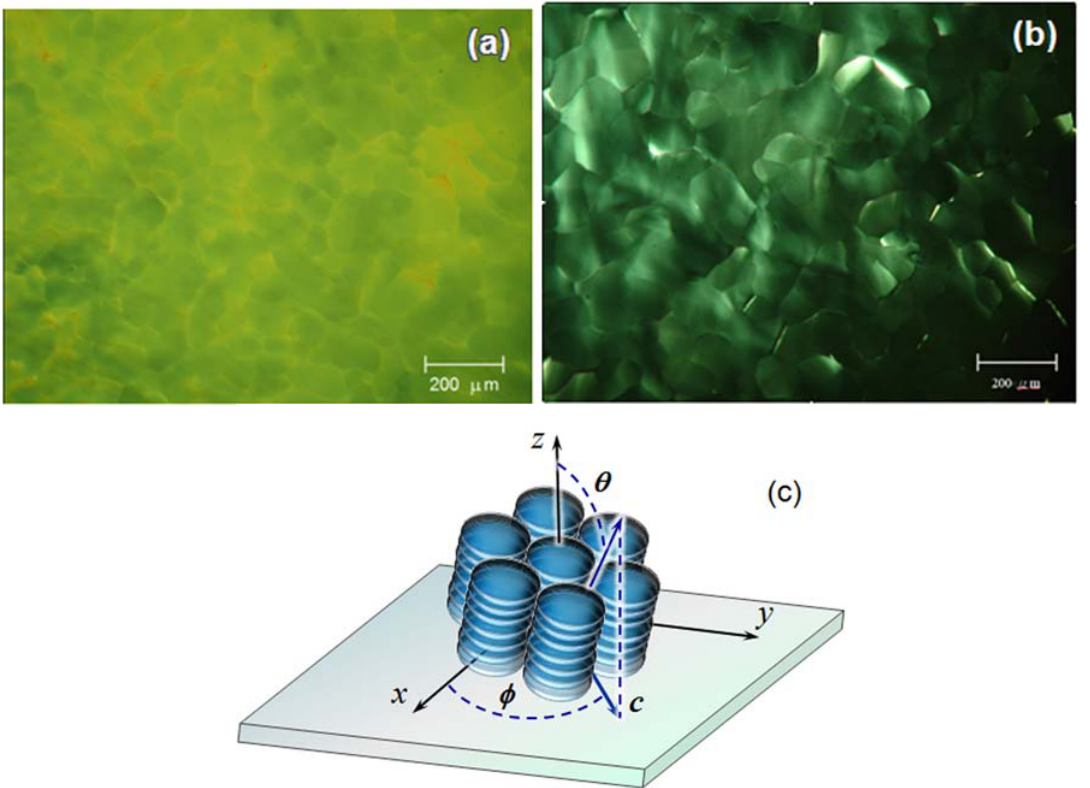
Figure 6. Photomicrographs of the LC10 layers in the cells with their substrates buffed by plasma for (a) 5 min and (b) 15 min. (c) Molecular tilt of homeotropically aligned DLC. O 2 Tilt angle  is defined as the angle between the director n of the DLC and the normal to the surface, i.e. , the z axis. The azimuthal angle  is defined as the angle between the project of n on the surface and the plasma buffing direction, which is parallel to the x axis.